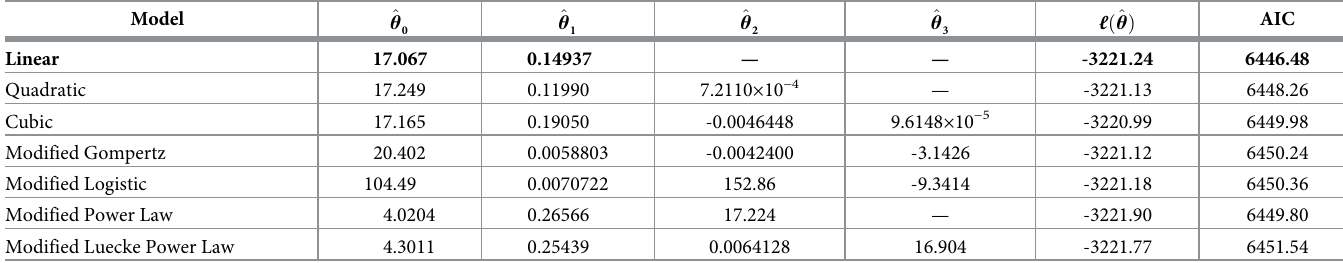
Table 7. Maternal fat mass models (mass in kg vs. fetal mass in kg for power law models, mass in kg vs. gestational age in weeks for all other